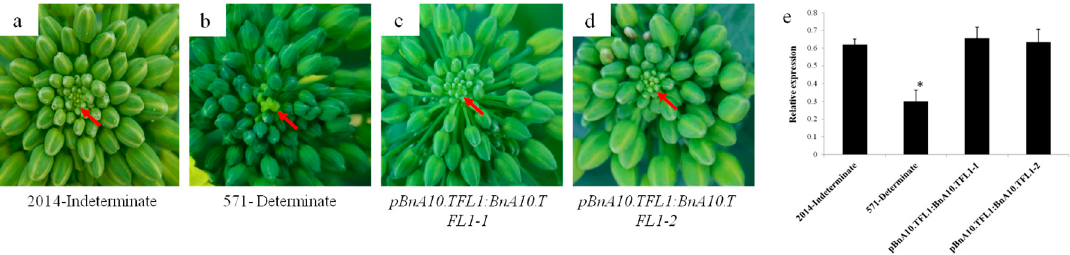
Figure 5. Architecture and BnA10.TFL1 expression in the inflorescence apex of transgenic positive plants in B. napus . ( a ) The 2014 line is naturally indeterminate. ( b ) The 571 line has a determinate inflorescence and abnormal floral organs. ( c , d ) B. napus transgenic plants positive for pBnA10.TFL1:BnA10.TFL1-1 and pBnA10.TFL1:BnA10.TFL1-2 show indeterminate phenotypes. ( e ) BnA10.TFL1 expression in transgenic positive plant inflorescence apexes in B. napus . Actin7 was used as the reference gene; the error bars show the standard errors from three biological replicates. * indicates significant differences at p < 0.05. The arrows indicate the inflorescence apexes.